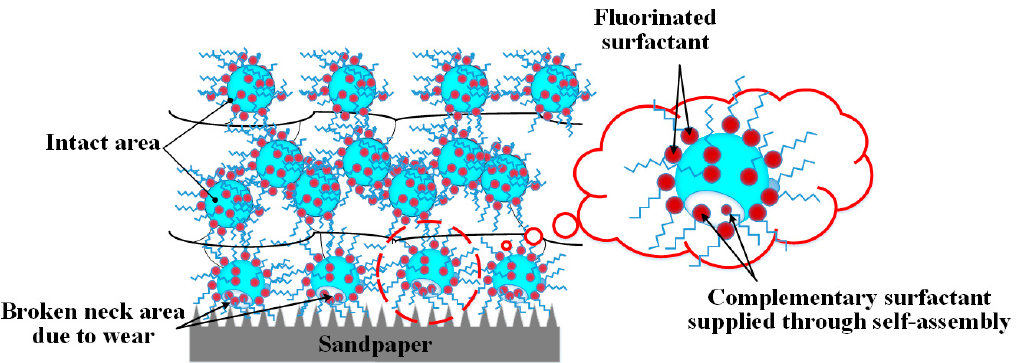
Figure 14. Schematic illustration of the wear-resistance mechanism.